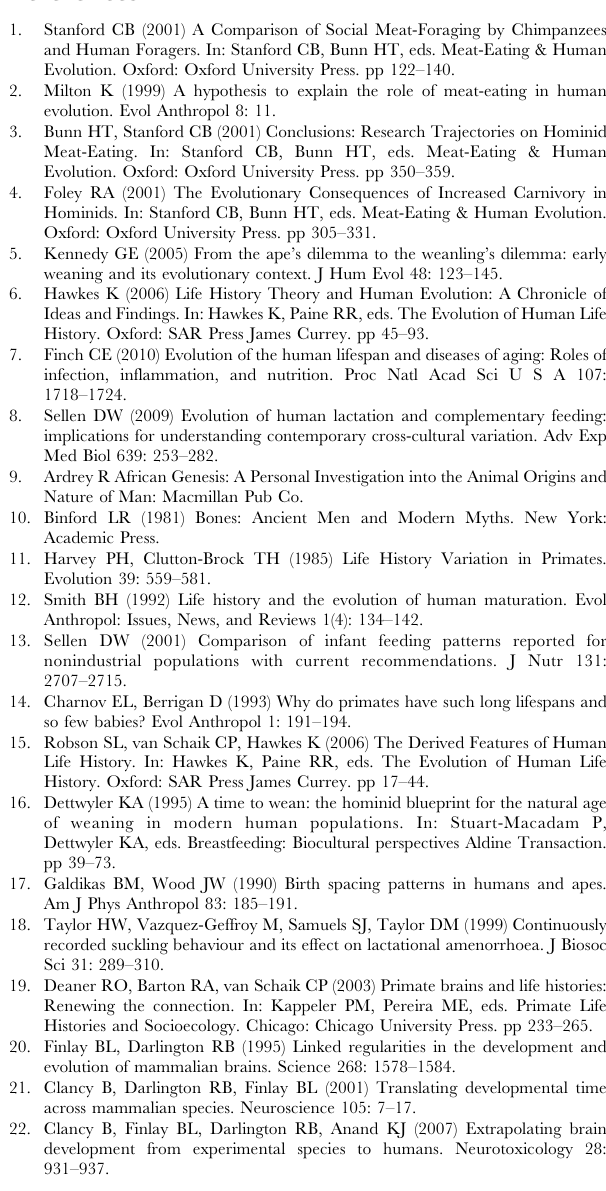
Table S3 Calibration points use for the construction of the tree in Fig. 1. *The split denotes the branch where the species-pair shares a last common ancestor. **For the TF algorithm one calibration points needs to be fixed. The fixed date was taken from: Hallstro¨m BM and Janke A. (2010) Mammalian evolution may not be strictly bifurcating. Mol Biol Evol 27:2804– 2816; see also Materials and